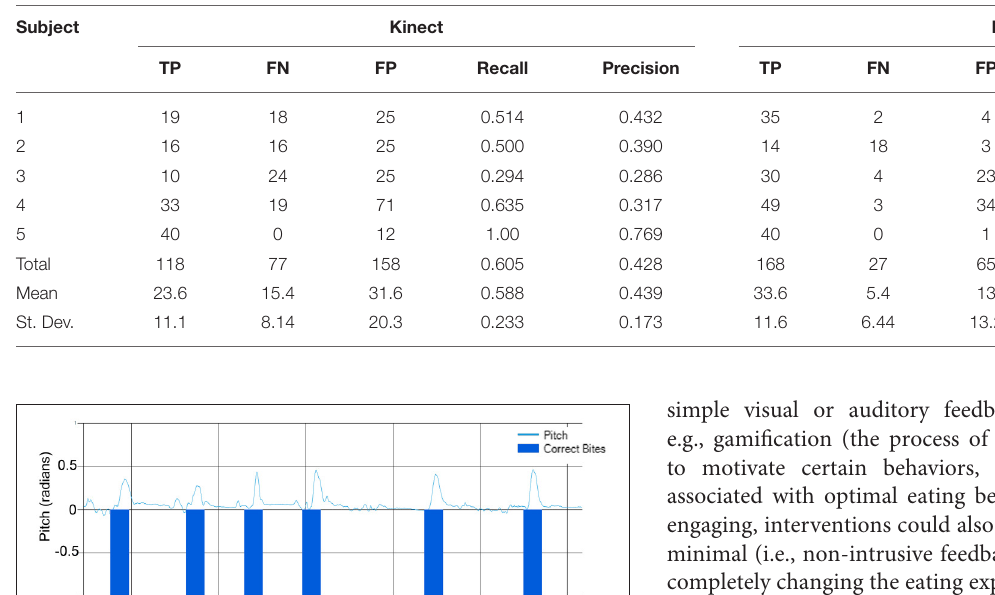
TABLE 3 | Single plate experiment bite detection results.